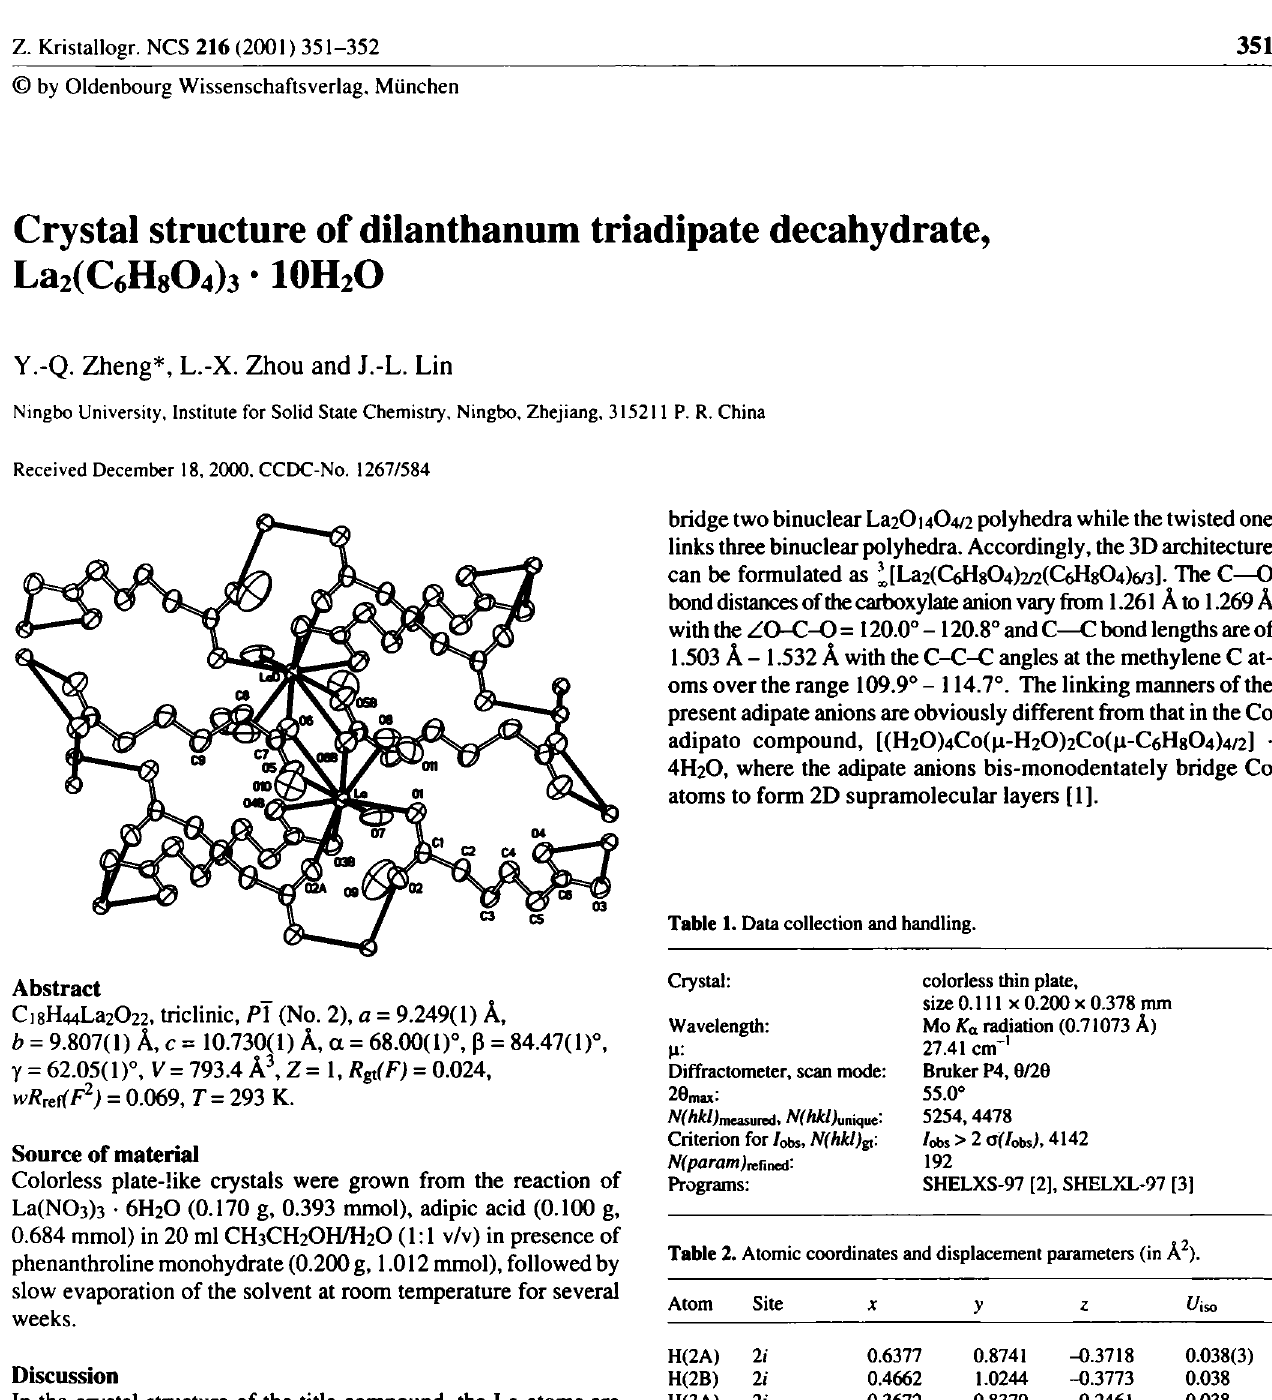
Table 2. Atomic coordinates and displacement parameters (in Ä 2